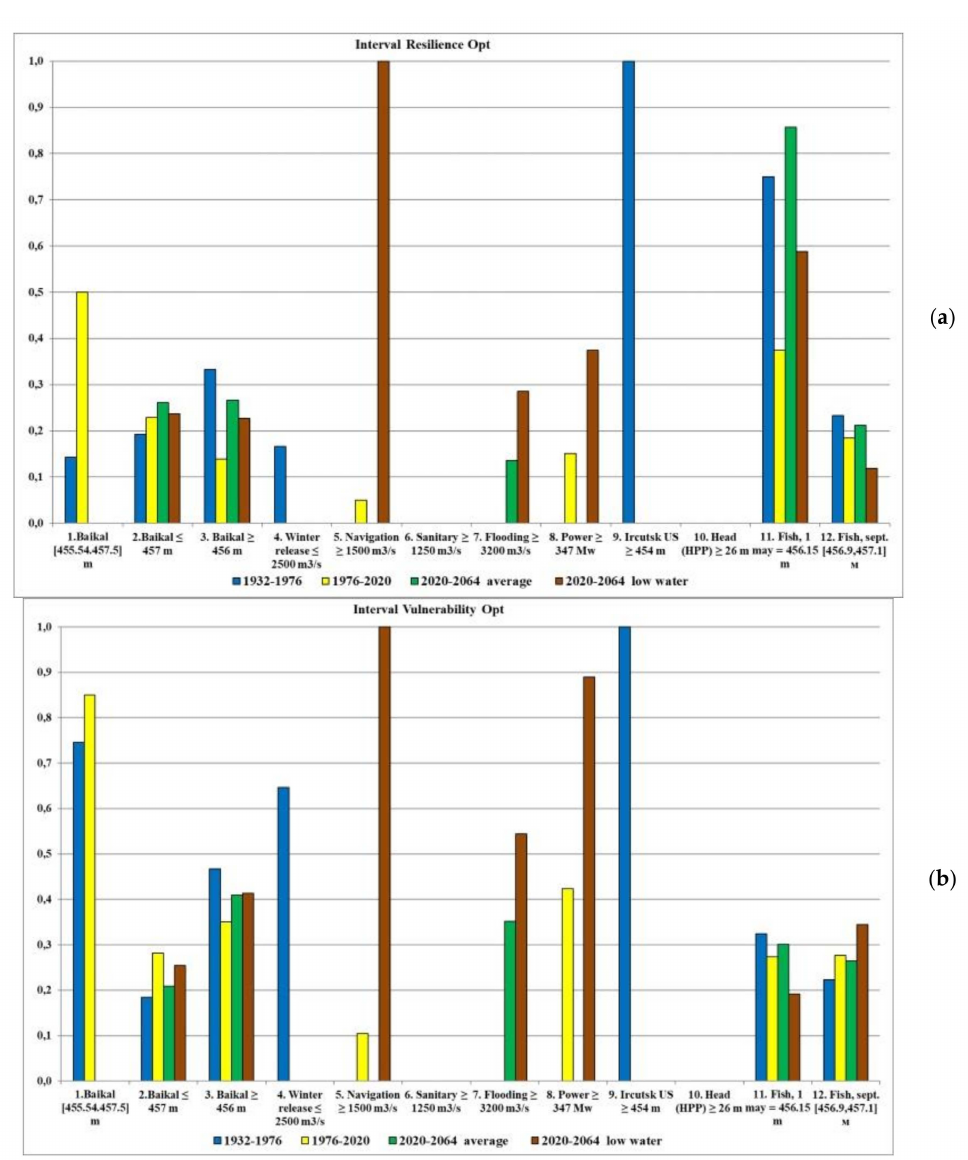
Figure 15. The resilience ( a ) normalized vulnerability ( b ) for different time series (optimization